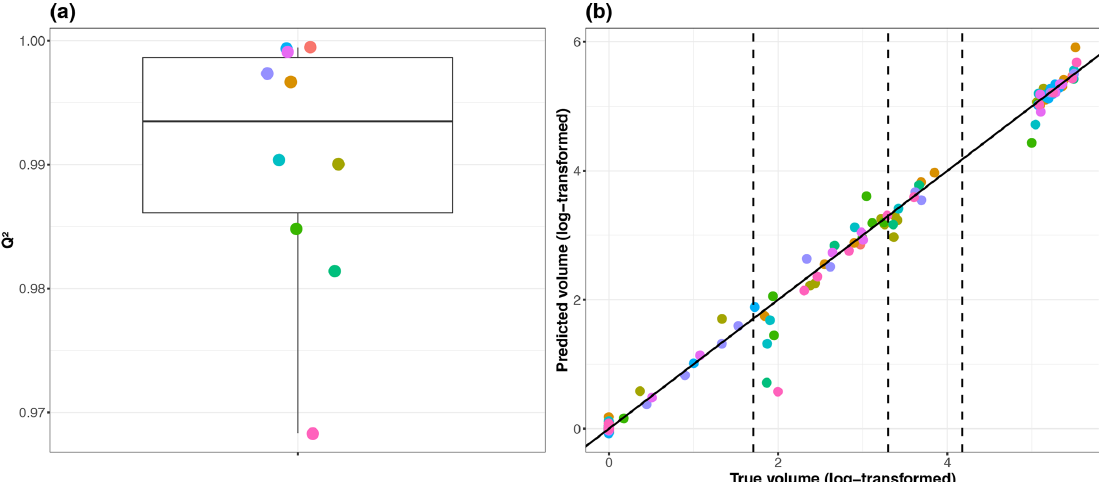
Figure 6. (a) Boxplot of performance indicator values Q 2 (for the 10 folds of the cross-validation procedure). Each colour indicates the number index of the corresponding fold. (b) Comparison between the volume (log 10 -transformed) estimated using the “true” numerical simulator and the ones predicted using the GP model for each of the 10 folds of the cross-validation procedure. The closer the dots are to the first bisector, the more satisfactory the predictive capability of the trained GP model is. The vertical dashed lines indicate the threshold Y C (log 10 -transformed) used in the study (50, 2000 and 15000m 3 ).